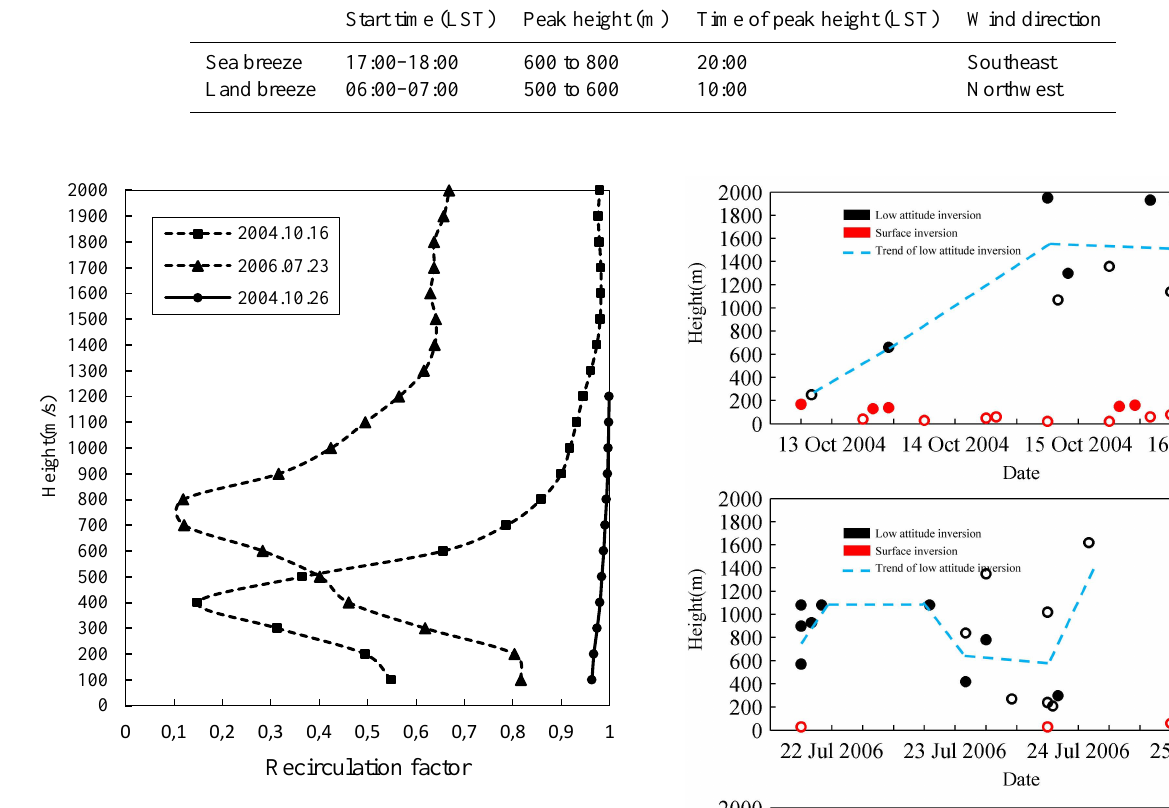
Fig. 9. RF at each height at the Xinken station on (a) 16 October 2004, (b) 23 July 2006, and (c) 26 October 2004.